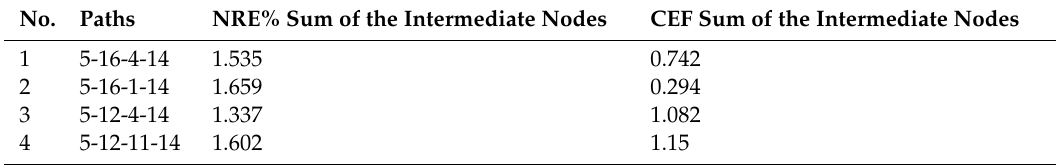
Table 4. Demand paths from node-5 to